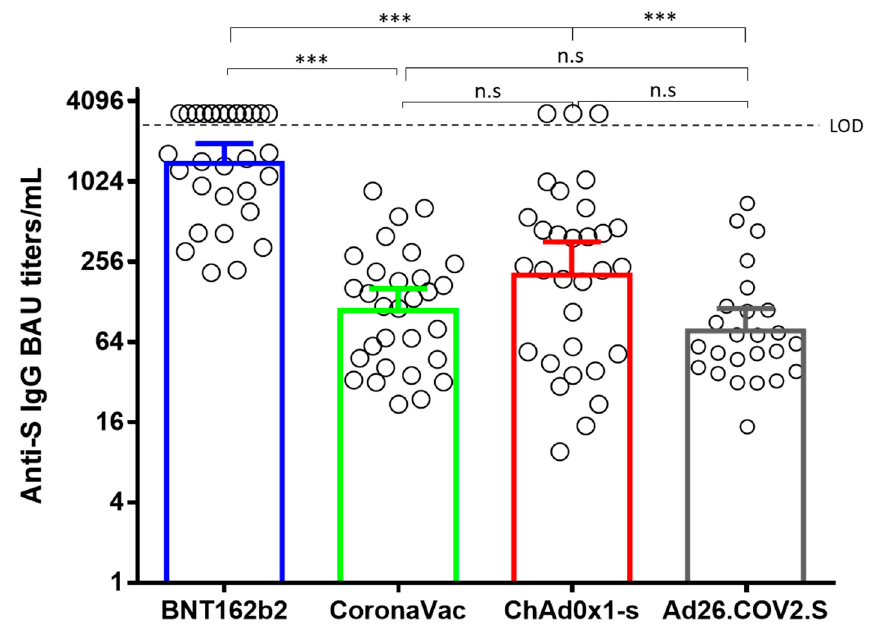
Figure 1. Comparison of geometric means of binding Anti-S IgG antibody titers. BAU: binding antibody units. ***: p < 0.0001. n.s: no significant. Table 1. Comparison of neutralizing and binding Anti ‐ S IgG antibody titers.